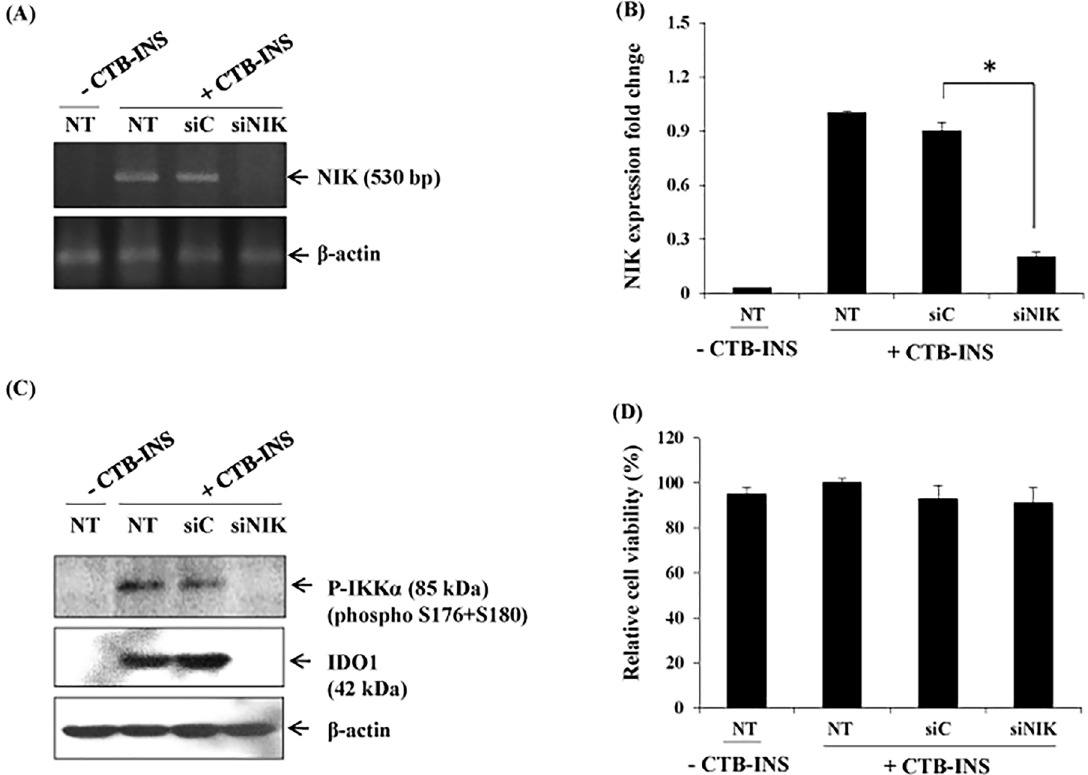
Fig 3. The non-canonical NF- κ B pathway is required for CTB-INS-induced IDO1 expression in monocyte-derived DCs. Panel (A) shows NIK mRNA levels in monocyte-derived DCs transfected with NIK-specific siRNA (siNIK) or negative control (siC) examined by RT-PCR using NIK specific primers. The β -actin gene was used as an internal standard in RT-PCR. This image is representative of two independent experiments. Panel (B) graphic representation of NIK mRNA levels in CTB-INS vaccinated and unvaccinated DCs. Panel (C) show the expression of IDO1 protein and phosphorylated IKK α in mDCs transfected with NIK-specific siRNA (siNIK) or negative control (siC) examined by Western blot analysis using anti-IDO1 as the primary antibody. This image is representative of three independent experiments. Panel (D) shows graphic representation of the cell viability of non-transfected or transfected with NIK- specific siRNA (siNIK) or negative control (siC) in mDCs. Dendritic cell viability was measured by determination of the percentage of vaccinated DCs negative for annexin V and propidium iodide. NT means non-siRNA CTB-INS transfected DCs, and – or + means without CTB-proINS and with CTB-INS. Samples were assayed in triplicates and the results represent the mean ± SD of three independent experiments p = 0.002. Statistical analysis was performed using one way analysis of variance